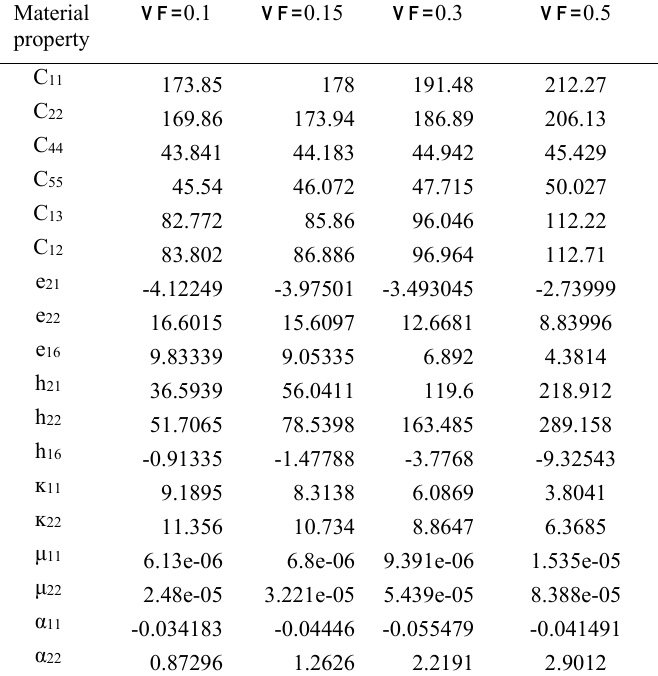
Table 3: Effective properties of fibrous magneto-electro- elastic composites constituted of a piezo-electric ( BaTiO 3 ) matrix reinforced by piezo-magnetic ( CoFe 2 O 4 ) inclusions (C ij in GPa; κ ij in 10 -9 C 2 /Nm 2 ; μ ij in Ns 2 /C 2 , e ij in C/m 2 ; h ij in N/Am and αij in 10 -9 Ns/VC).